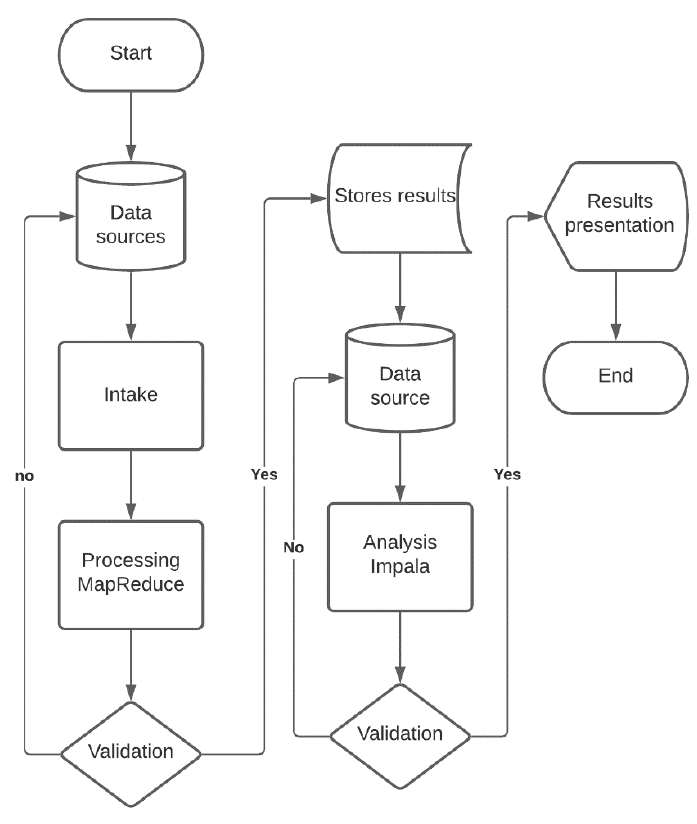
Figure 4. Block diagram of the operation of the data analysis framework.